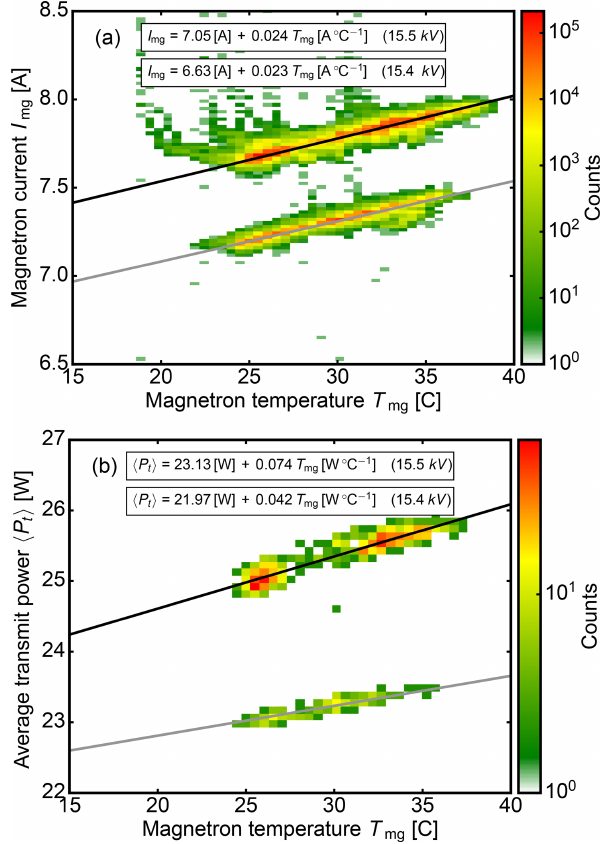
Figure A1. Analysis of the relationship between magnetron tem- perature T mg , magnetron anode current I mg and average transmit power (cid:104) P t (cid:105) during a 27-day ground-based test campaign in 2016 for two different anode voltages (15.4 and 15.5kV). (a) Relationship between magnetron temperature T mg and magnetron anode current I mg . (b) Relationship between magnetron anode current I mg and average transmit power (cid:104) P t (cid:105)